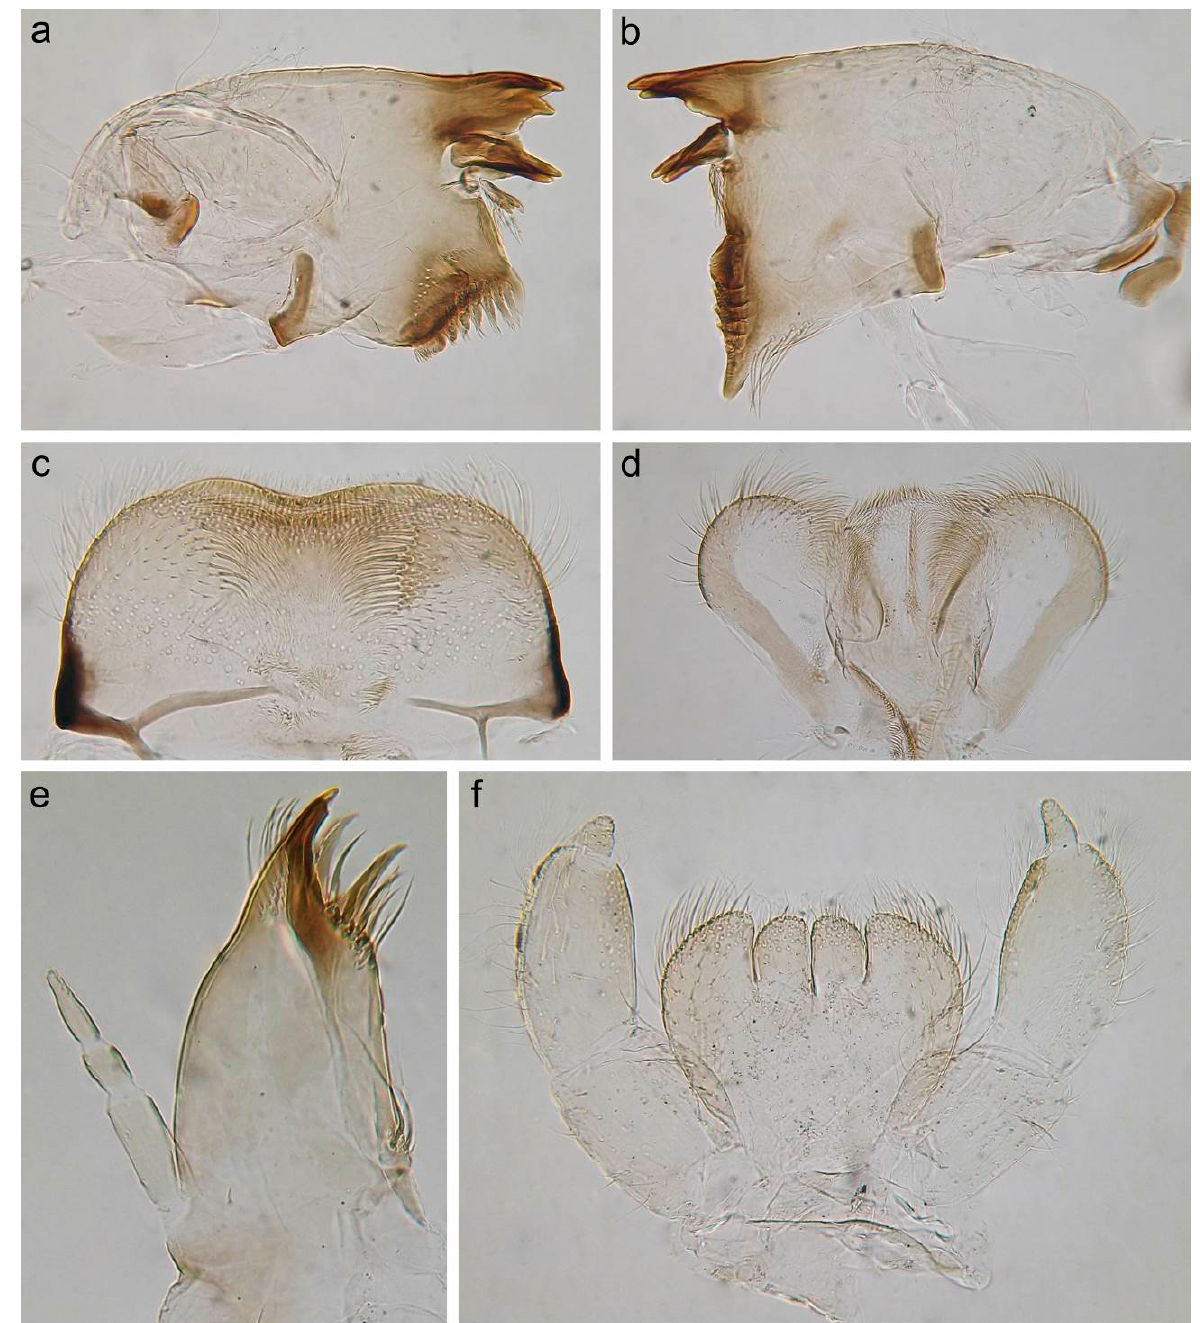
Figure 2. Larva of Serratella leonidi Martynov & Palatov, sp. nov. , paratype. ( a ) Angulate mandible,